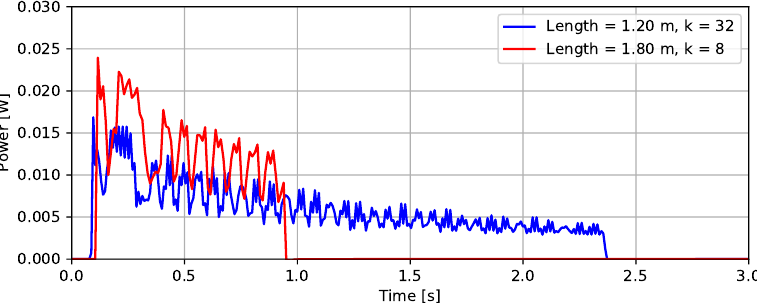
Figure 6. Power profiles for a 1.20 m long probe with 32 averaged measurements and a 1.80 m long probe with 8 averaged measurements.